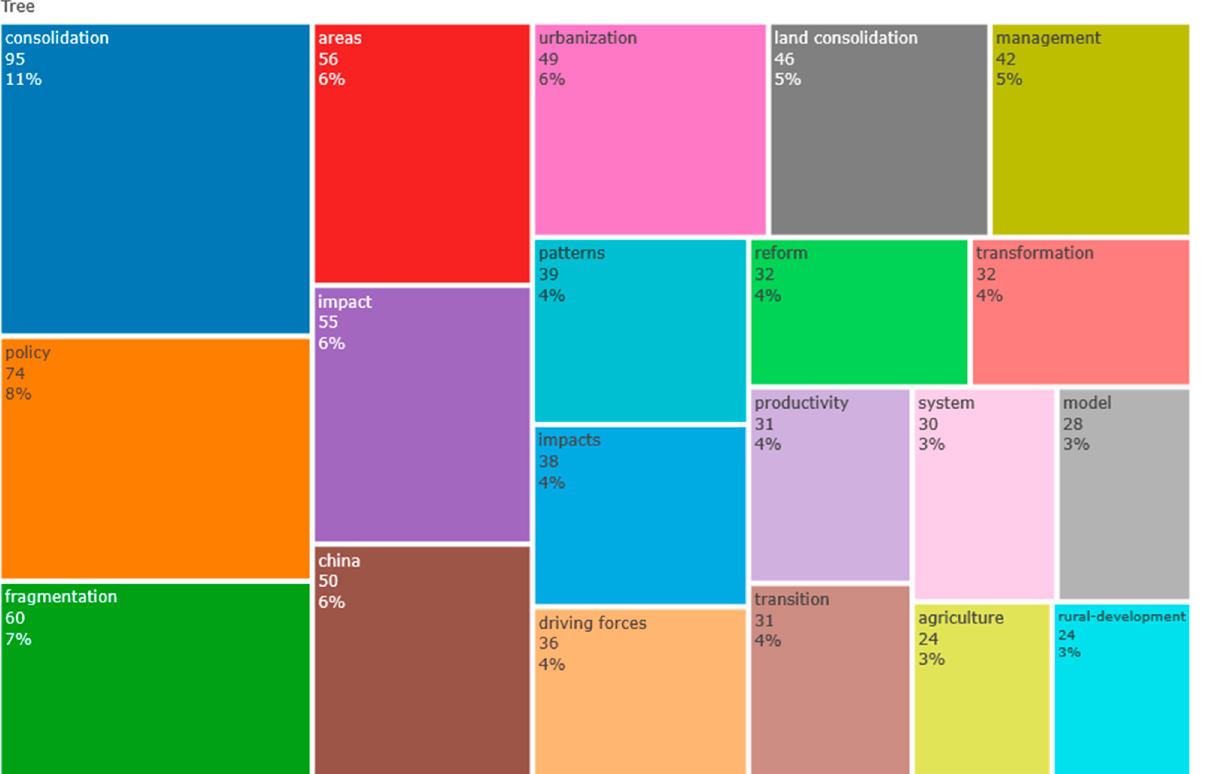
Figure 7. Word tree of keywords in land consolidation and rural revitalization studies from 1950 to 2021.